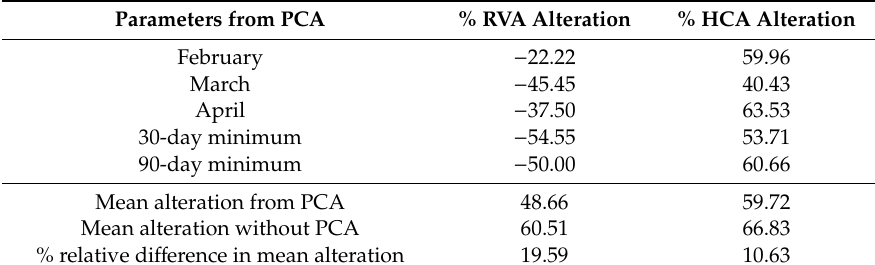
Table 8. Percentage alteration for RVA and HCA using IHA parameters from PCA.